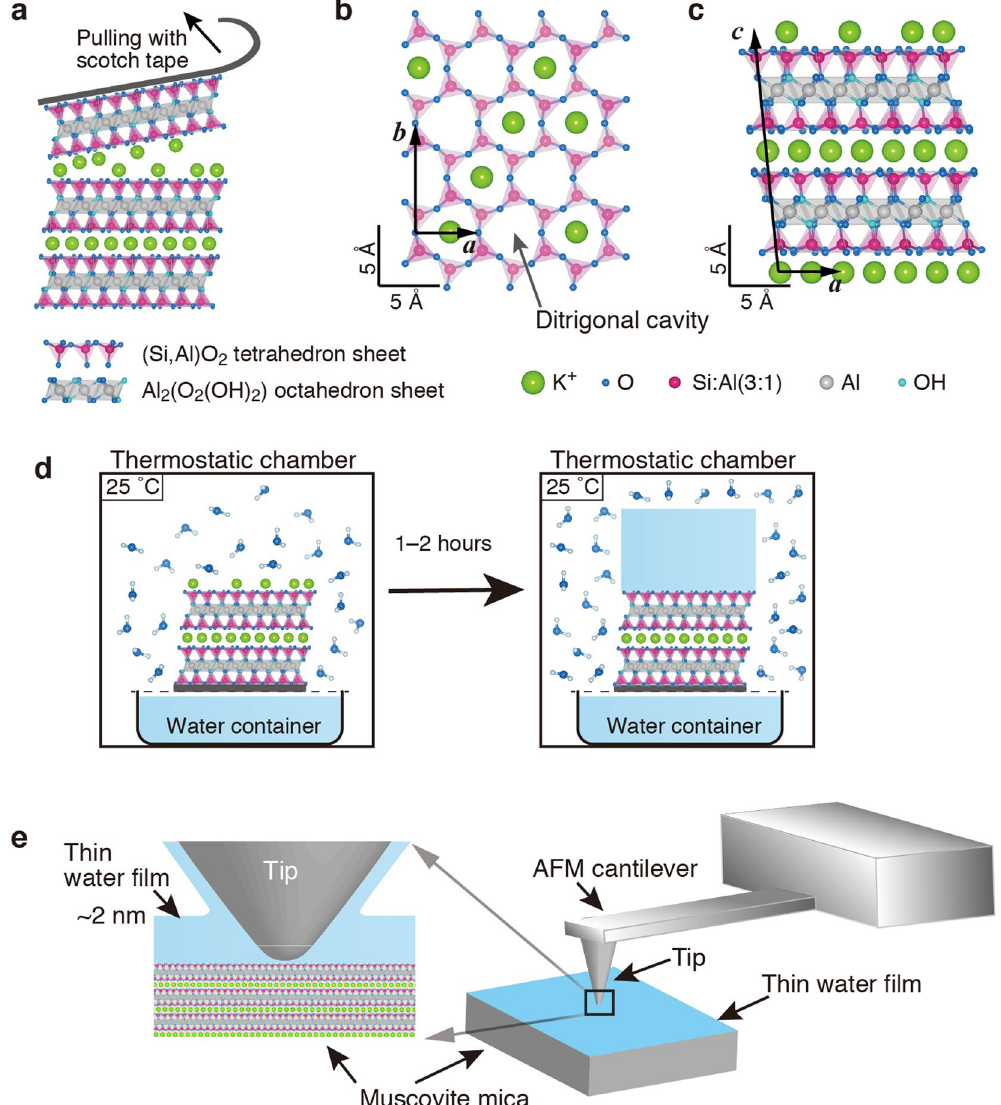
Figure 1. Schematics of preparation of a thin water film on muscovite mica and FM-AFM imaging of the water film. ( a ) Cleavage of muscovite mica along the (001) plane using Scotch tape under ambient laboratory conditions. The cleavage occurs along the K + layer between the two SiO 2 tetrahedron sheets. Each K + ion usually remains on either tetrahedron sheet at a fifty-fifty rate after cleavage. ( b ) Atomistic model of the cleaved muscovite mica (001) surface. The (001) surface composed of a hexagonal network of (Si,Al)O 2 and K + ions located over the ditrigonal cavities of the network. ( c ) Side view of the [010]-directional projection. Adjoining two rows of K + ions, running in the [100] direction, on the top of (001) surface are depicted in the projection. K + ions, O atoms, Si atoms, Al atoms, and OH groups are shown in green, blue, pink, grey, and light blue, respectively. The Si atoms are replaced by Al atoms at an Si:Al ratio of 3:1. a , b , and c are unit vectors for the unit cell of muscovite mica. | a | = 5.1579 Å, | b | = 8.95 Å, | c | = 20.071 Å, α = 90.00°, β = 95.75°, and γ = 90.00° 39 . The model was drawn using VESTA 52 . ( d ) Formation of a thin water film on the muscovite surface. The sample was set in the AFM setup, which was in a Peltier-type thermostatic chamber at 25 °C with a water bath. A small water container was also placed just below the sample to keep the humidity high near the sample. The water vapour gradually condensed on the muscovite surface, resulted in formation of a thin water film. ( e ) AFM imaging of the thin water film on the muscovite surface with an AFM cantilever. Only the tip apex at the end of the cantilever is immersed in the water film. The tip is also covered with a thin water film in humid